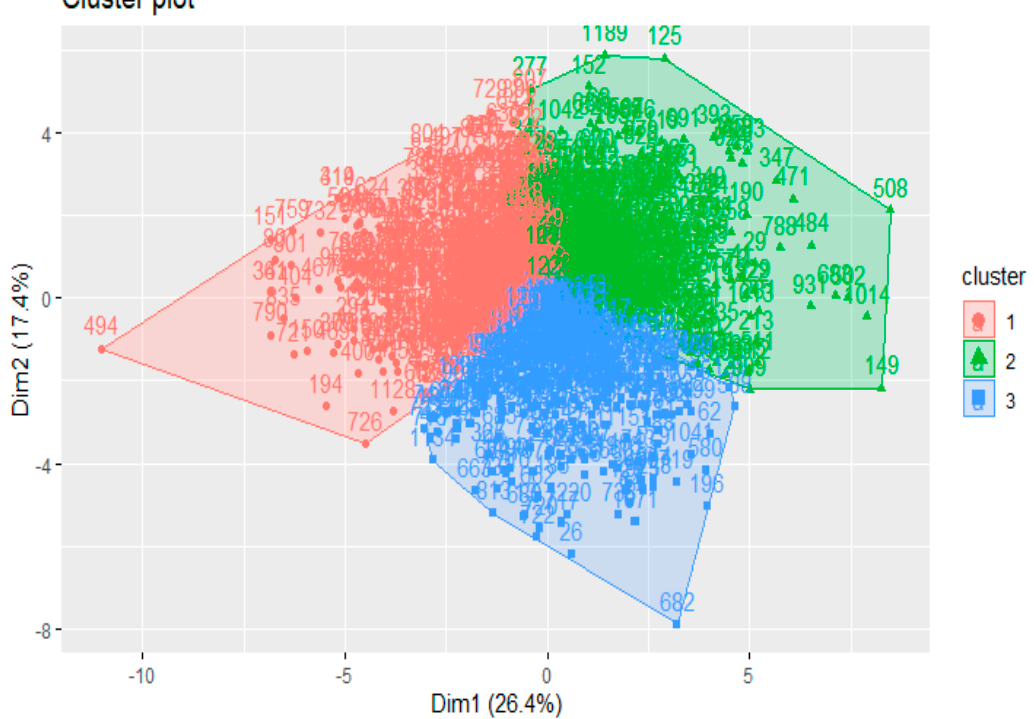
Figure 1. Ordinal diagram of the distribution of variables obtained from the Schwartz Value Survey (SVS) and Portrait Values Questionnaire (PVQ) projection on two principal components, three cluster solution.